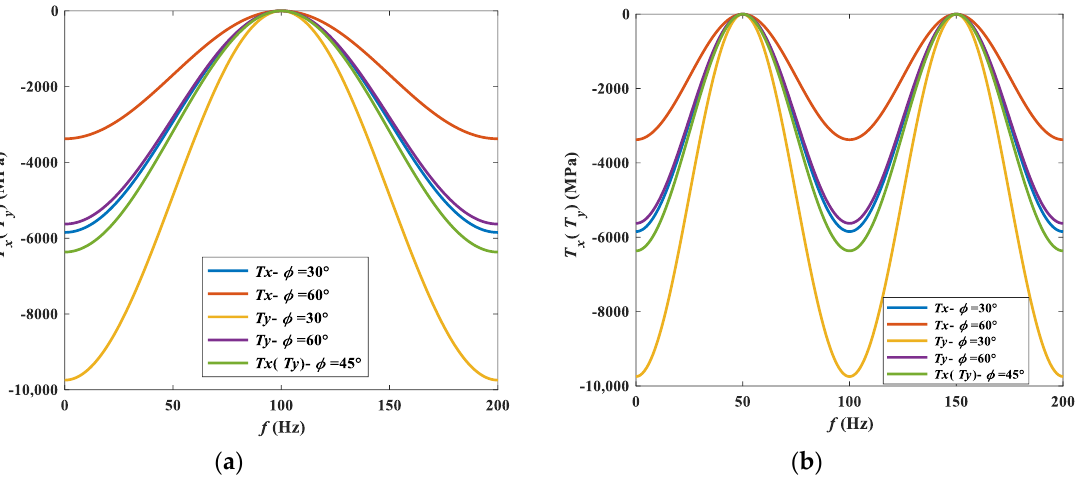
Figure 6. Variation of T-stress with the frequency of harmonic dynamic load at different rotation angles φ : ( a ) t = 0.005 s; ( b ) t = 0.01 s.